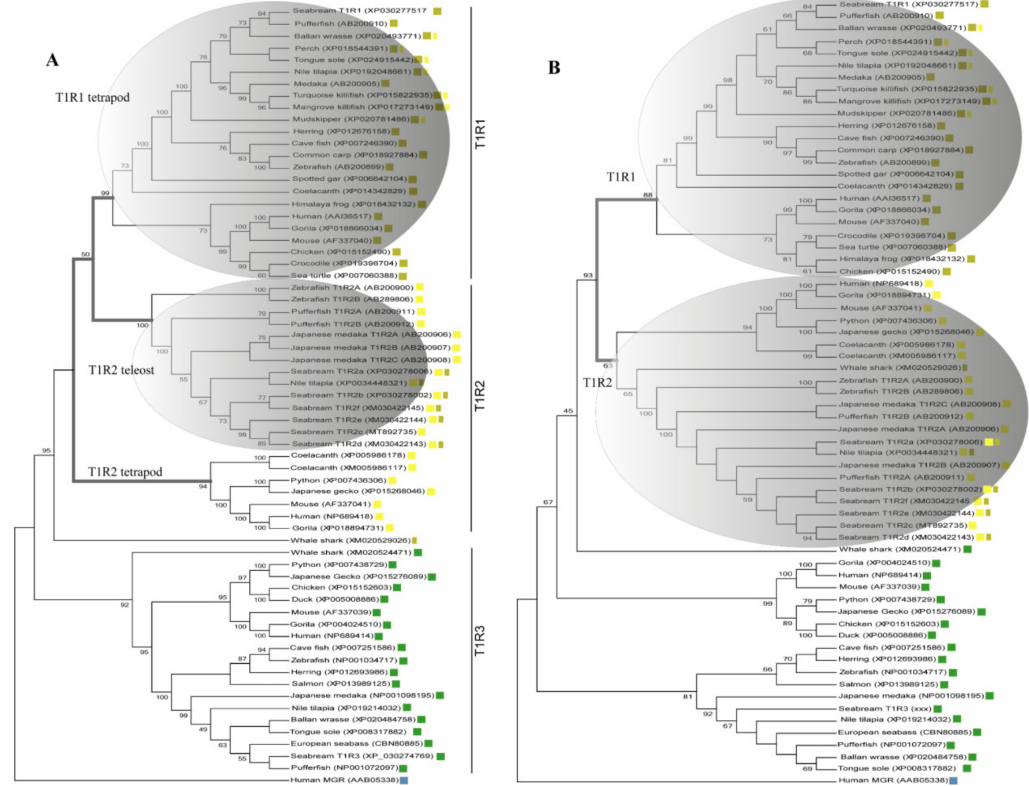
Figure 1. Phylogenetic relationships inferred by Maximum Likelihood (ML) method of CDS-( A ) and VFD-( B ) trees using multiple alignments of deduced AA sequences of vertebrate T1Rs ortholog genes. Both evolutionary reconstructions cluster saT1R1 , saT1R2a / b / c / d / e / f and saT1R3 genes in three distinct clades ( T1R1 ; T1R2 ; T1R3 ) each comprising their respective ortholog genes from mammals, amphibians, birds and reptiles. The ( A ) topology sets teleost T1R2 genes evolutionarily closer to T1R1 than T1R2 of tetrapod, while two compact T1R1 and T1R2 vertebrate clades are observed in the VFD ( B ) topology (grey line branches ). T1R1 fish AA sequences as deduced from our